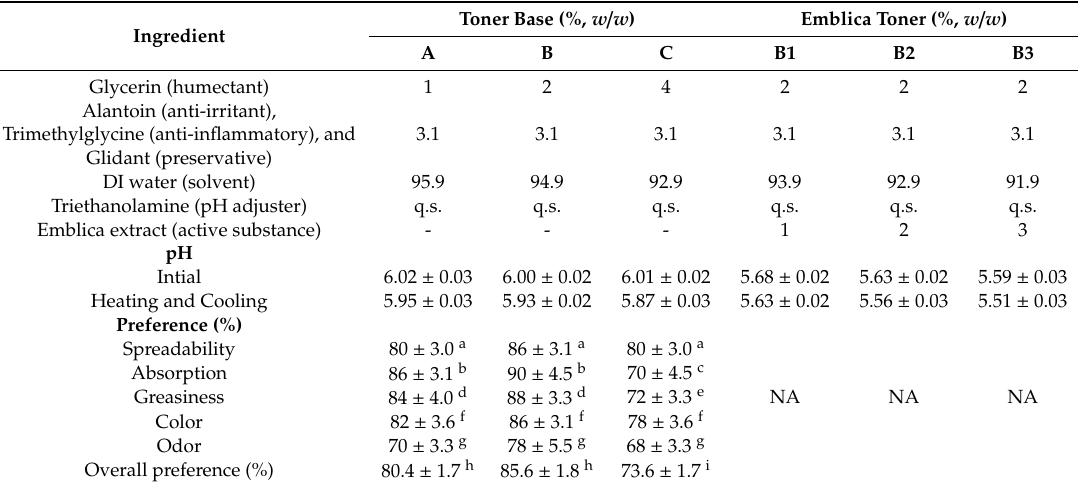
Table 1. Development of the stable emblica